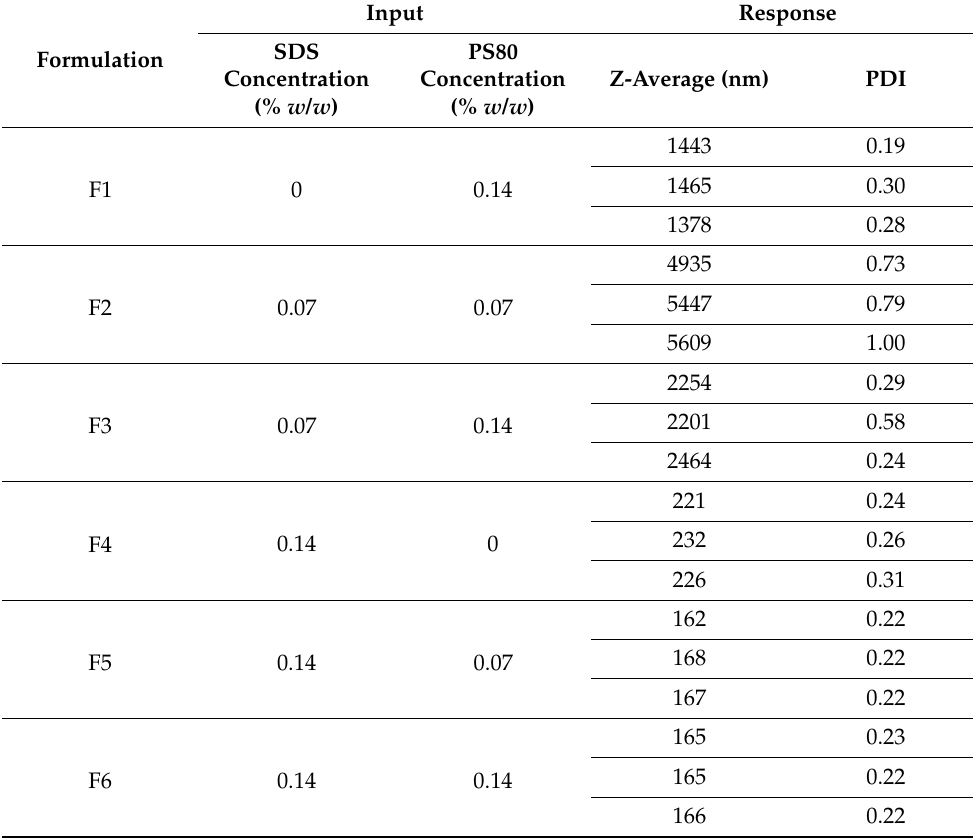
Table 2. Input variables and response parameters of the statistical evaluation of the stabilizer concentrations after 8 h of milling. HPC-SL concentration was kept constant in all experiments (0.9% ( w / w )). PDI: Polydispersity